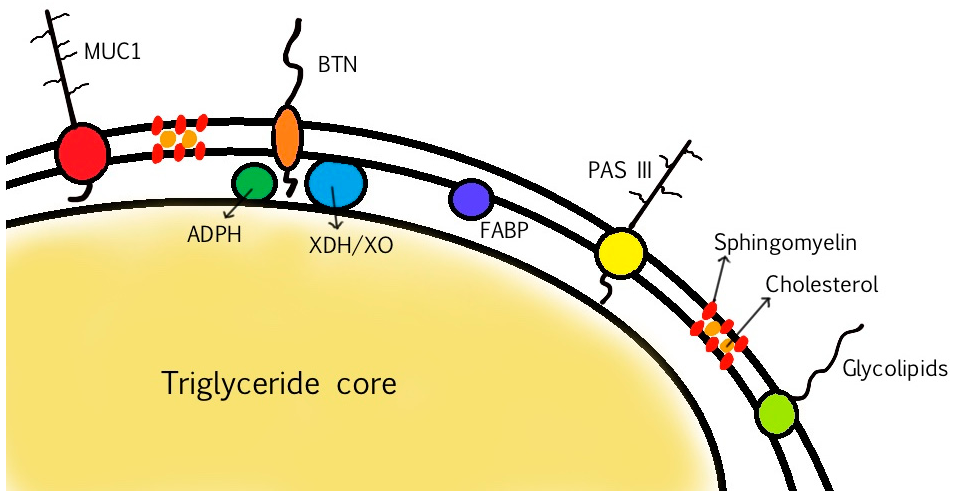
Figure 2. Structure of MFGM and localization of the main MFGM proteins.